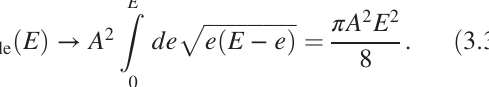
FIG. 21. The spectrum for a single realization of the coupled SYK model with N symmetry sectors. In each of the sectors, the spectrum is symmetric under E → − E . The sectors with Q ¼ (cid:5) 1 = 2 mod 4 contain the ground state separated by a gap from the rest of the